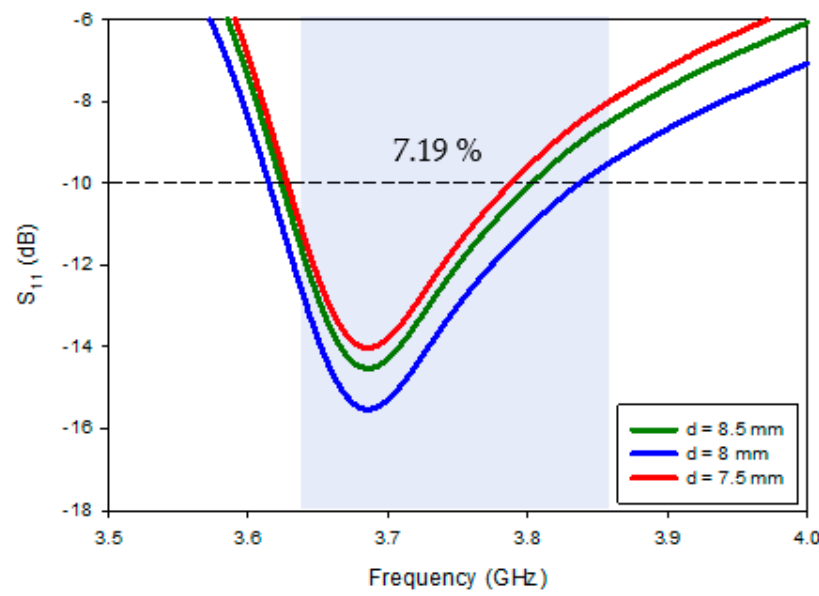
Figure 3. Reflection coefficients of the RDRA feed at various distances.